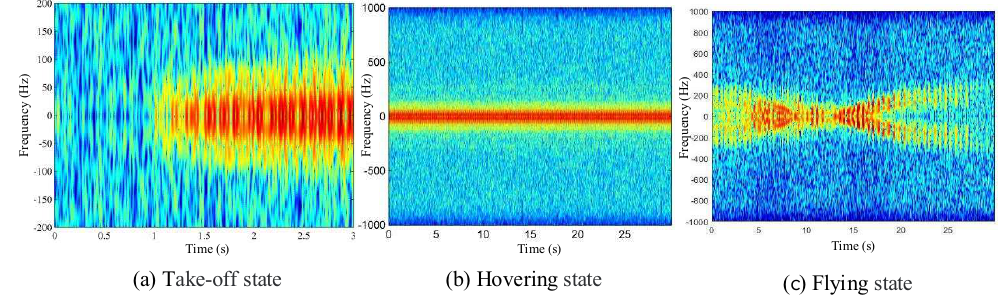
Figure 3. Micro-Dppler signature of different status of